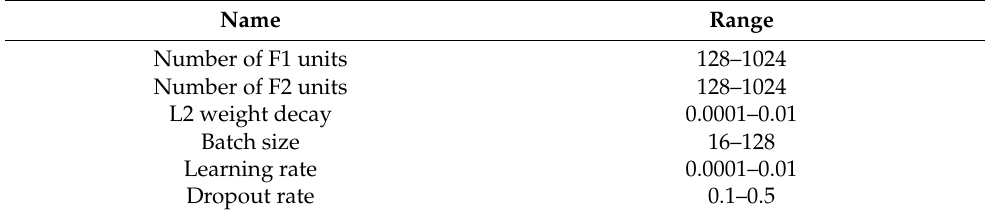
Table 2. Range of hyperparameters to be optimized on MNIST.